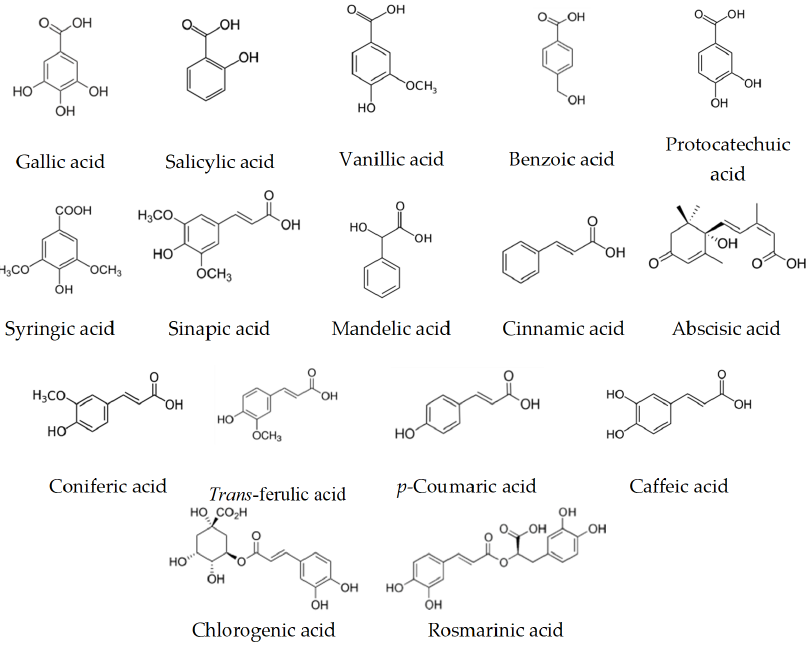
Figure 5. Phenolic acids have been reported in different types of SBH.